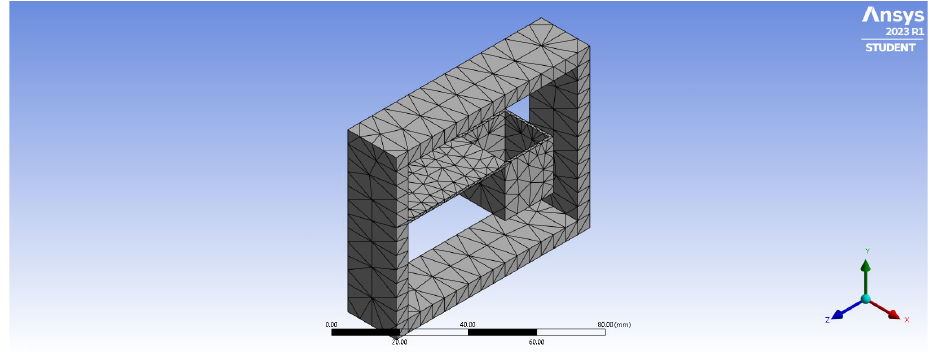
Figure 4. Mesh of the cantilever ‐ based FBG accelerometer.